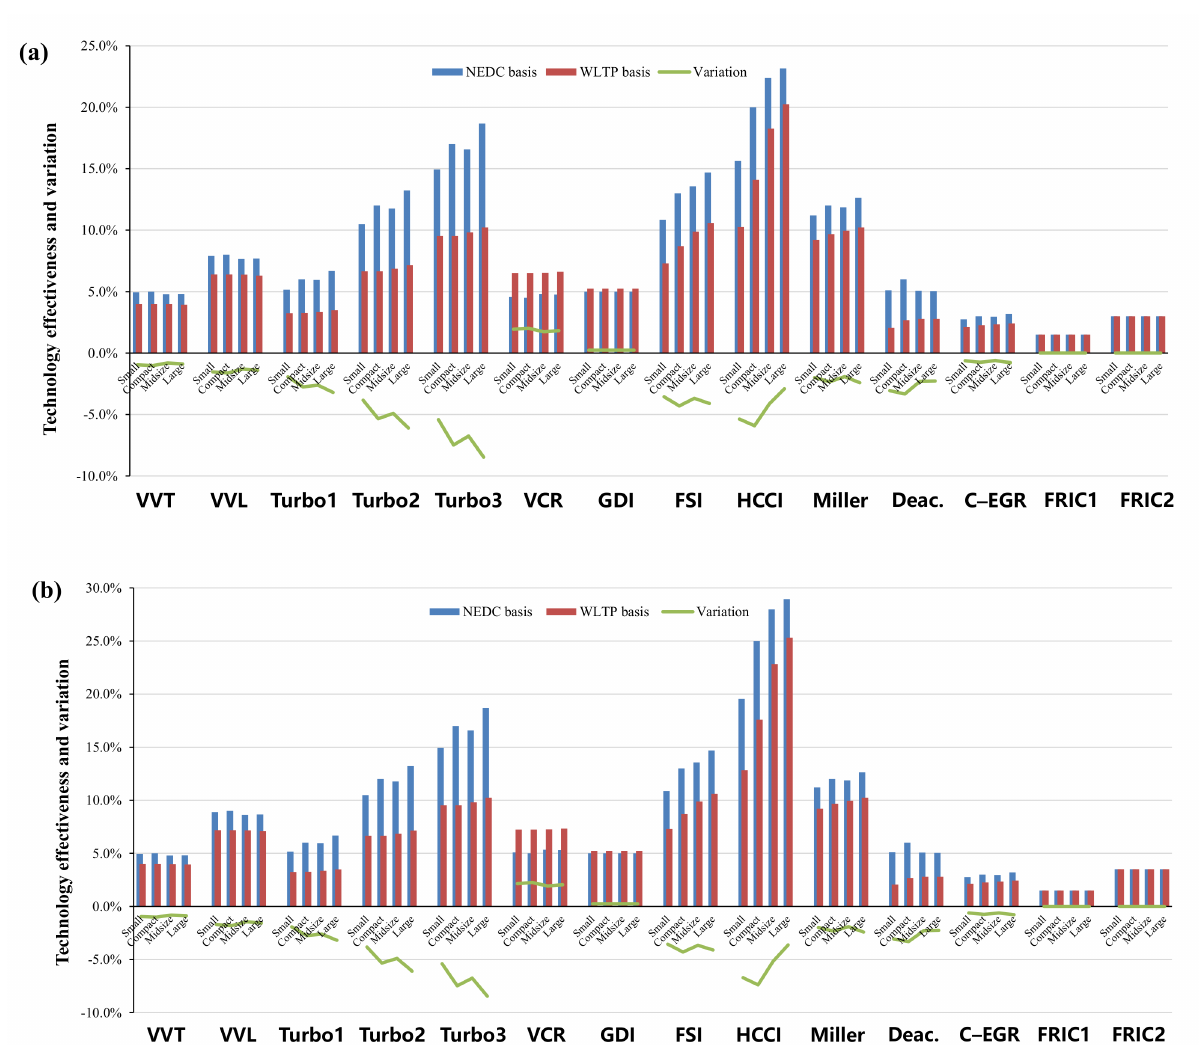
Figure 5. ( a , b ): Comparisons of advanced gasoline engine technologies in 2025 and 2030. Notes. (1) Turbo1, Turbo2, and Turbo3 represent mild downsizing (15% cylinder content reduction), medium downsizing (30% cylinder content reduction), and strong downsizing ( ≥ 45% cylinder content reduction) respectively. (2) FRIC1 and FRIC2 represent a 20% and 40% reduction in engine friction respectively